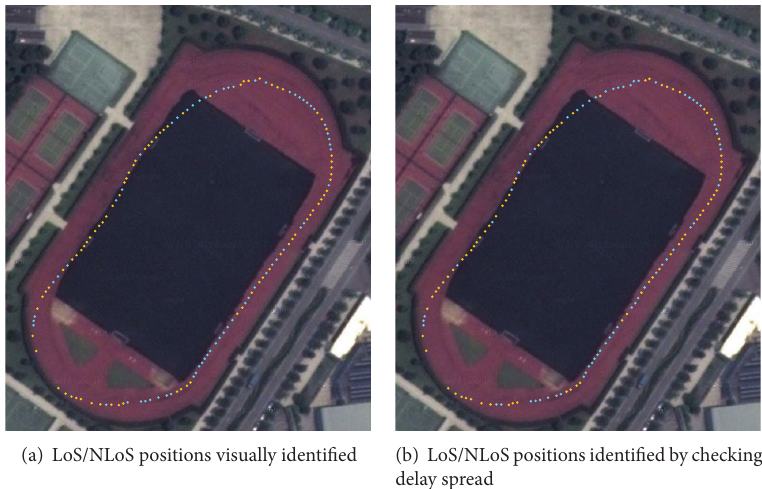
Figure 13: Comparison of the LoS/NLoS positions visually identified and detected based on delay